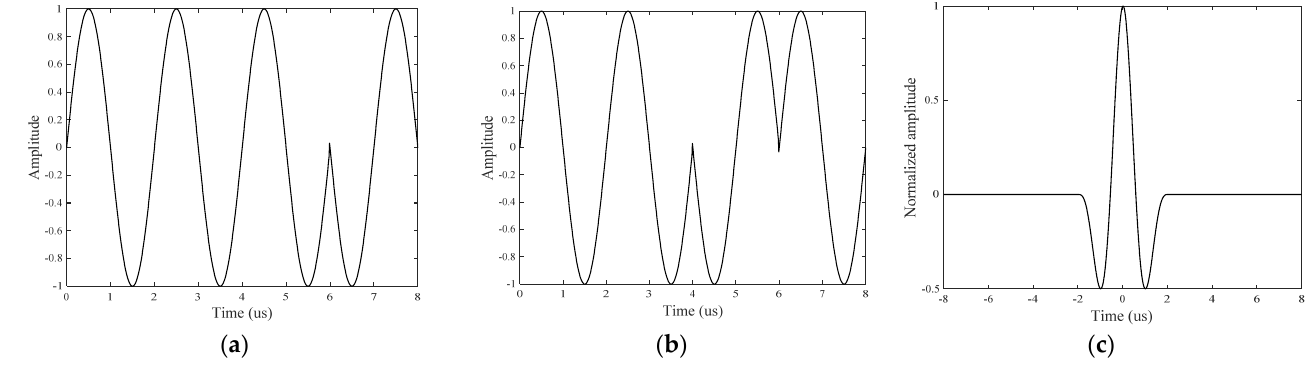
Figure 2. GCC signal: ( a ) sequence A; ( b ) sequence B; and ( c ) autocorrelation curve.